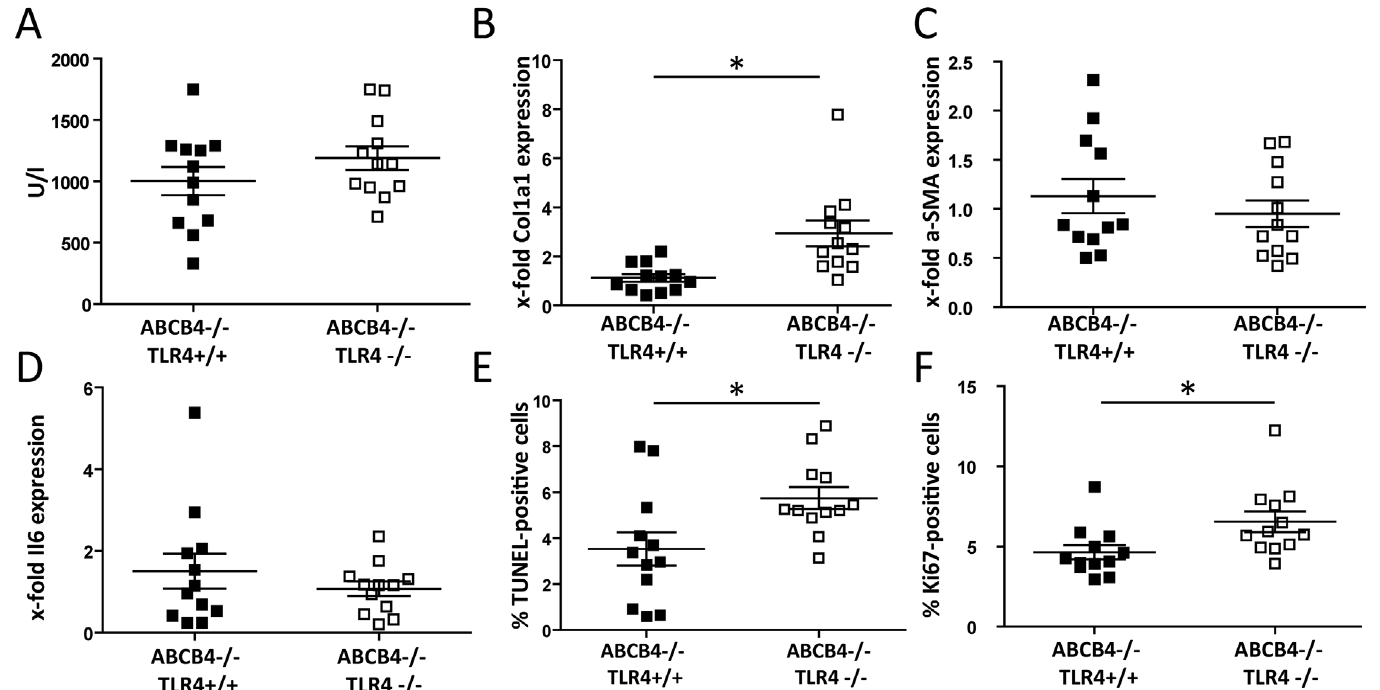
Fig 3. TLR4 deficiency increases apoptosis and proliferation at early fibrotic stages. ABCB4-deficient and ABCB4/TLR4-double-deficient mice were subjected to DEN at 7 weeks of age (n = 12 per line; 6 males, 6 females). (A) Plasma ALT activities, measured in U/l. (B) Relative hepatic Col1a1 mRNA expression. ABCB4 -/- :TLR4 +/+ mice were set as 1. (C) Relative hepatic a-SMA mRNA expression. ABCB4 -/- :TLR4 +/+ mice were set as 1. (D) Relative hepatic Il6 expression. ABCB4 -/- :TLR4 +/+ mice were set as 1. (E) Hepatocellular apoptosis rate. (F) Hepatocellular proliferation rate. * p < 0.05.